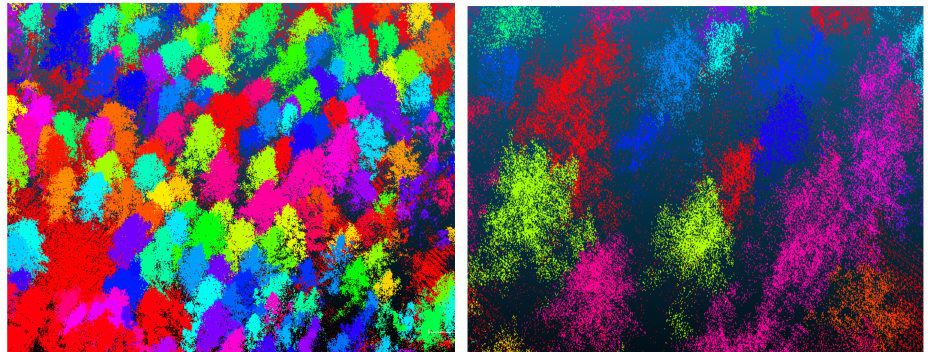
Figure 5. Schematic diagram of single tree